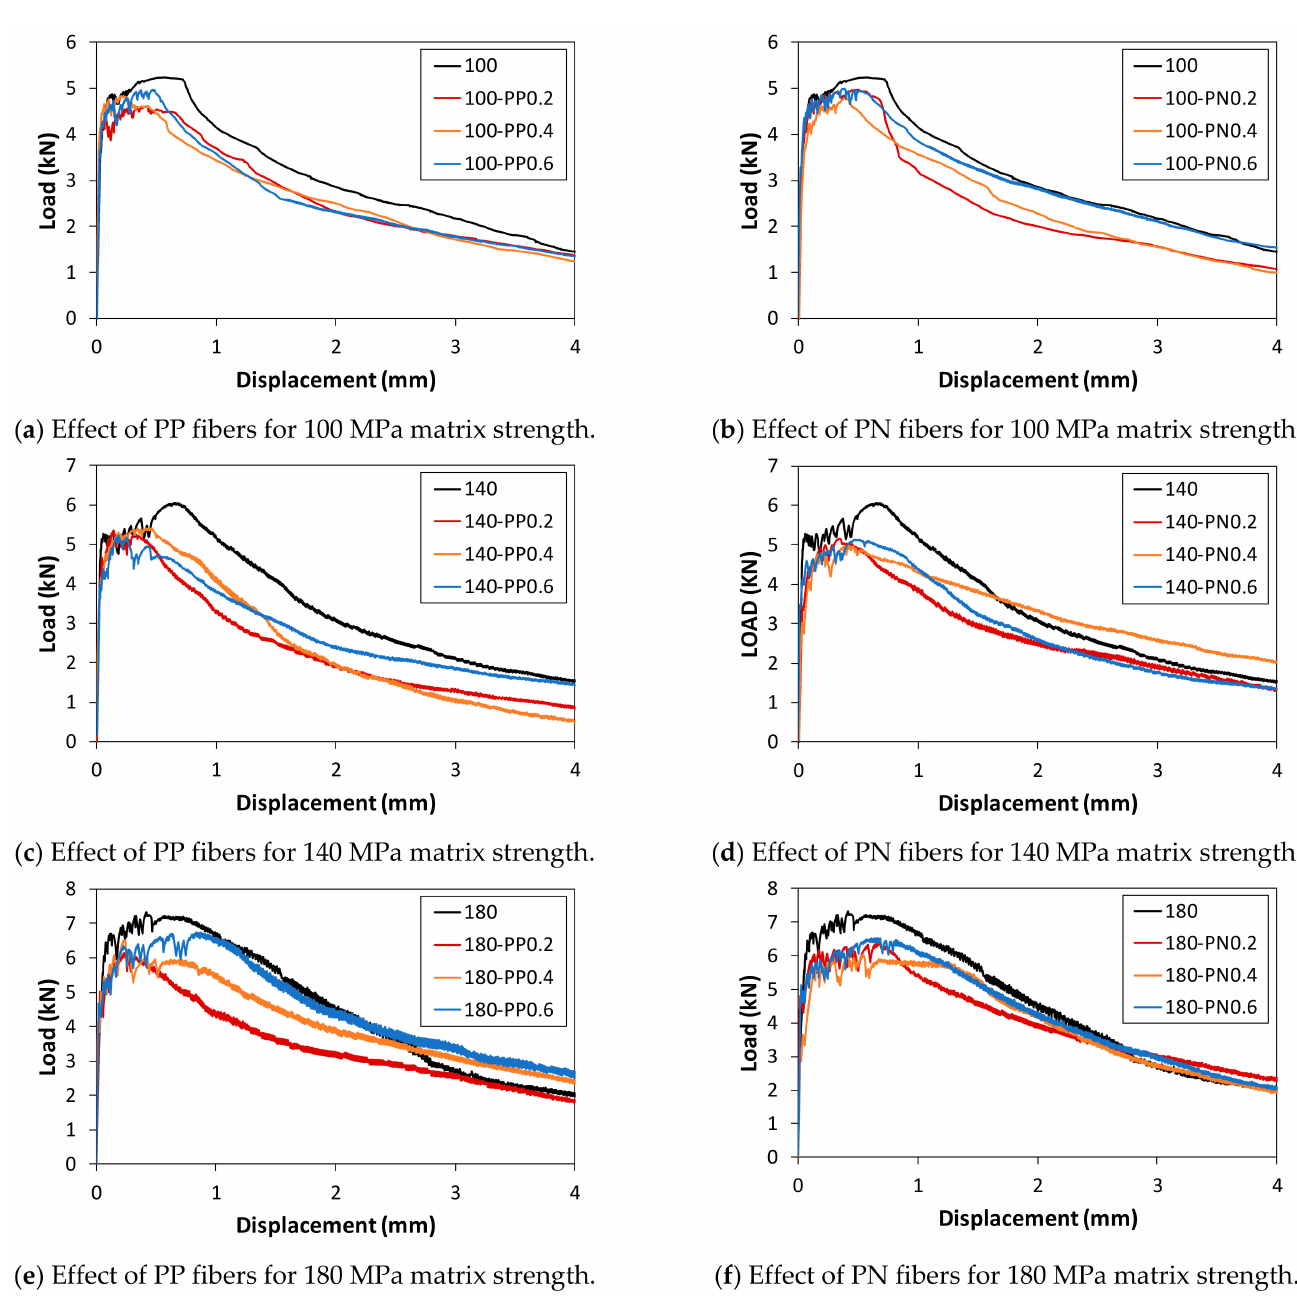
Figure A3. Load–displacement curves before conducting fire